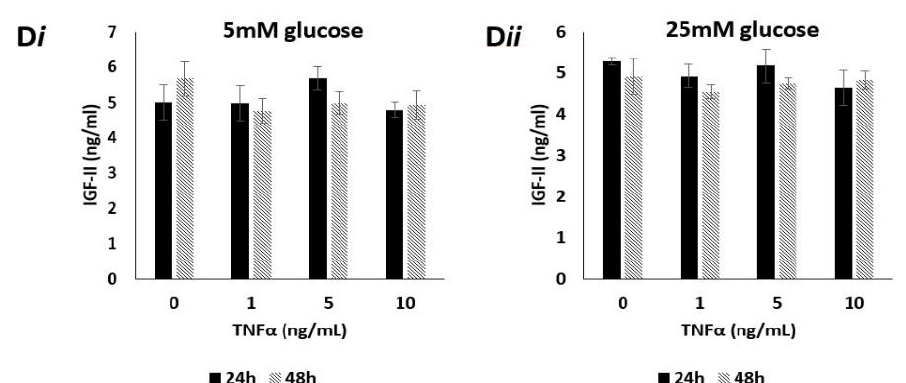
Figure 2. IGF-II allelic expression, imprinting behaviour and peptide expression after treatment with TNF α , in prostate cancer cell lines using APA1 RFLP, PIE, qPCR and RIA analyses. ( A ) Gel image depicting the effects of TNF α upon IGF-II allelic expression in the PC3 cell line, after 24 h exposure. Cells cultured in 5mM ( i ) glucose and dosed with 10 ng/mL TNF α showed two bands, sized 229 and 292 bp, indicating a change from mono- to biallelic IGF-II expression and, therefore, loss of imprinting. Cells cultured in 25 mM ( ii ) glucose and dosed with 0, 1, 5 and 10 ng/mL TNF α showed two bands sized 229 and 292 bp, indicating a change from mono- to biallelic IGF-II expression and, therefore, loss of imprinting. ( n = 3). ( B ) Imprinting percentage change of PC3 cells after exposure to TNF α for 24 h in 5 mM ( i) and 25 mM ( ii ) glucose. Cells cultured in 5 mM glucose media ( i ) and dosed with 1, 5 and 10 ng/mL TNF α all showed highly significant ( p < 0.001) decreases in imprinting percentage; those cultured in 25 mM glucose media ( ii ) and dosed with 5 and 10 ng/mL TNF α , also showed highly significant ( p < 0.001) decreases in imprinting percentage when compared with the control. ( n = 3). ( C ) IGF-II and H19 mRNA relative expression in the PC3 cell line, after treatment with TNF α in 5 mM ( i ) and 25 mM ( ii ) glucose for 24h, using qPCR; ( i ) a significant increase in IGF-II was observed in cells dosed with 1, 5 and 10 ng/mL TNF α . No significant fold changes in H19 mRNA were observed ( n = 3). ( ii ) No significant fold changes in IGF-II mRNA were observed. A significant decrease in H19 was observed in cells dosed with 1ng/mL TNF α , whilst a significant increase was observed in those dosed with 10ng/mL TNF α . ( D ) The effects of glucose and TNF α upon IGF-II peptide after 24 and 48 h exposure to 5 mM ( i ) and 25 mM glucose ( ii ) combined with increasing doses of TNF α , quantified using RIA. There were no significant changes in the quantities of IGF-II peptide. after 24 and 48 h exposure to 5 ( i ) or 25 mM ( ii ) glucose, when combined with increasing doses of TNF α . ( n = 3). (* p = 0.05, ** p = 0.01 and *** p < 0.001)